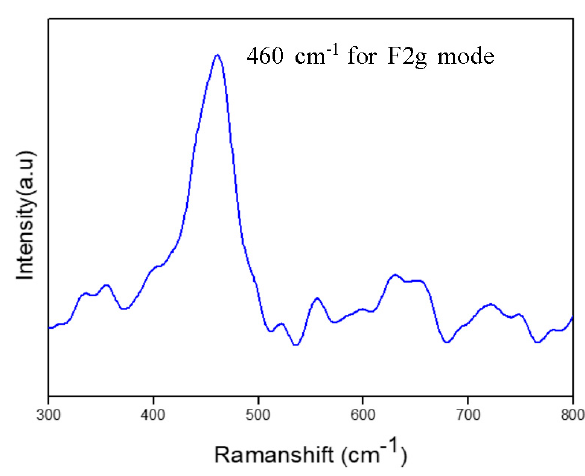
Figure 5. Raman spectrum of CeO 2 -ZnO NPs.